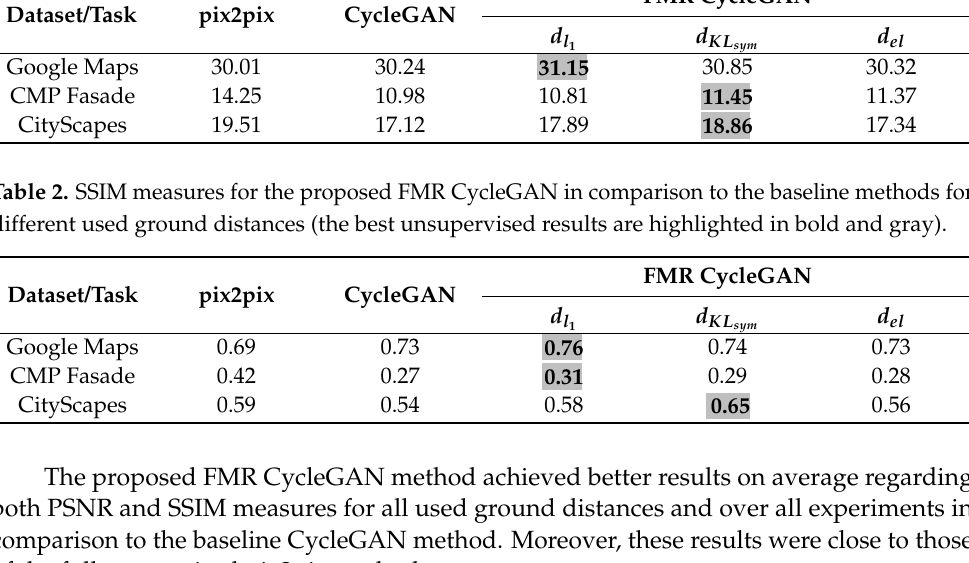
Table 1. PSNR measures for the proposed FMR CycleGAN in comparison to the baseline methods for different used ground distances (the best unsupervised results are highlighted in bold and gray). Dataset/Task